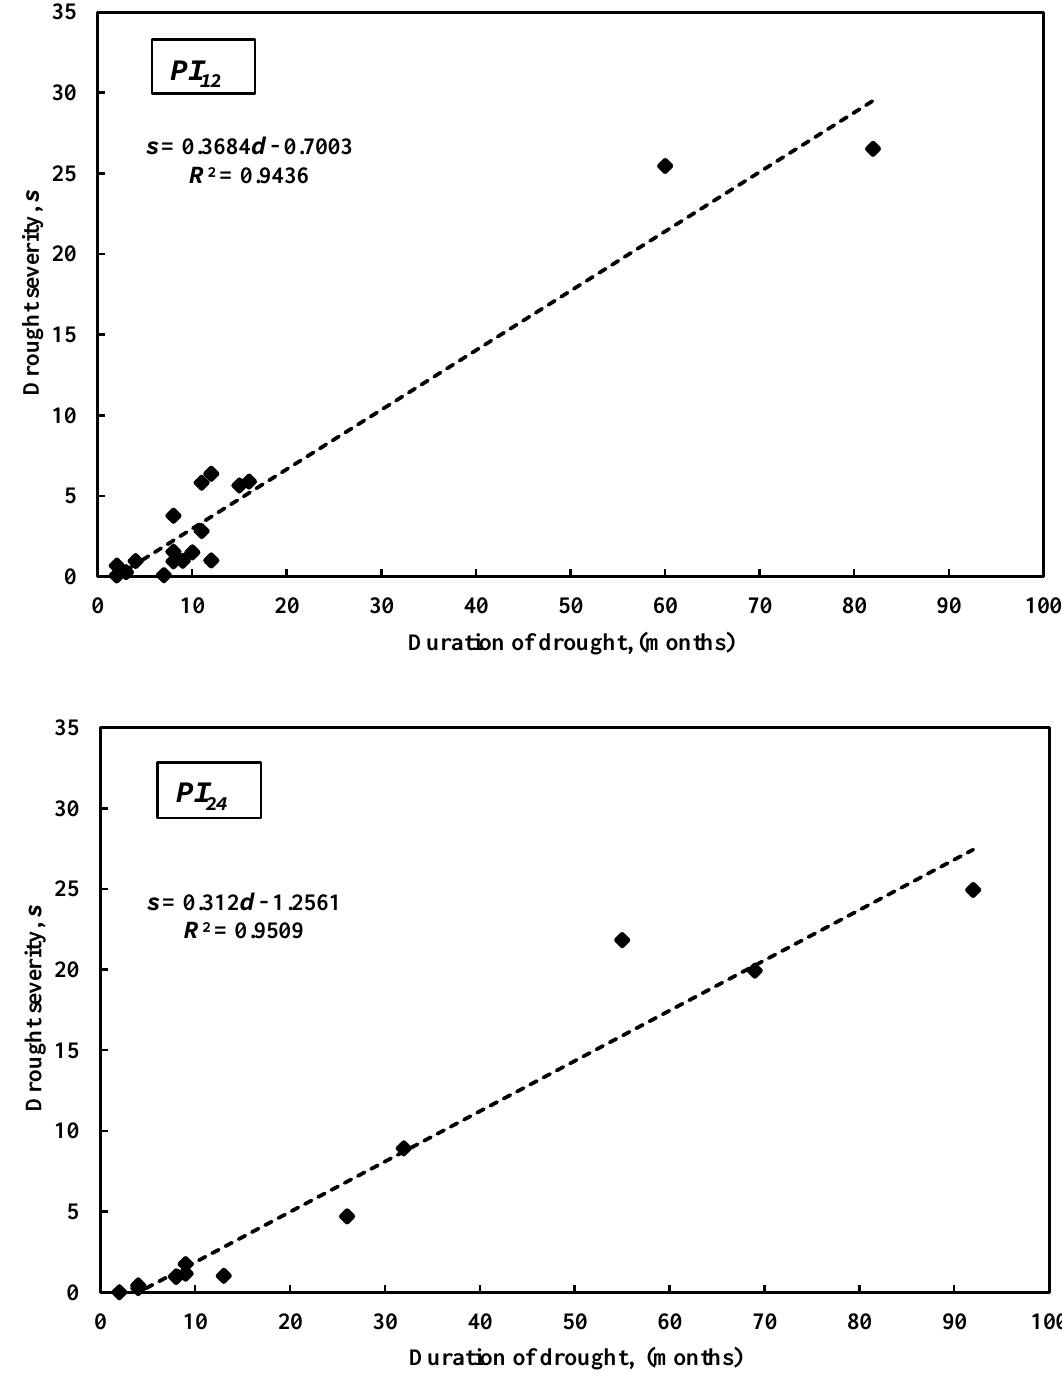
Figure 7. Drought severity versus duration of drought for 12- and 24-month timescales.